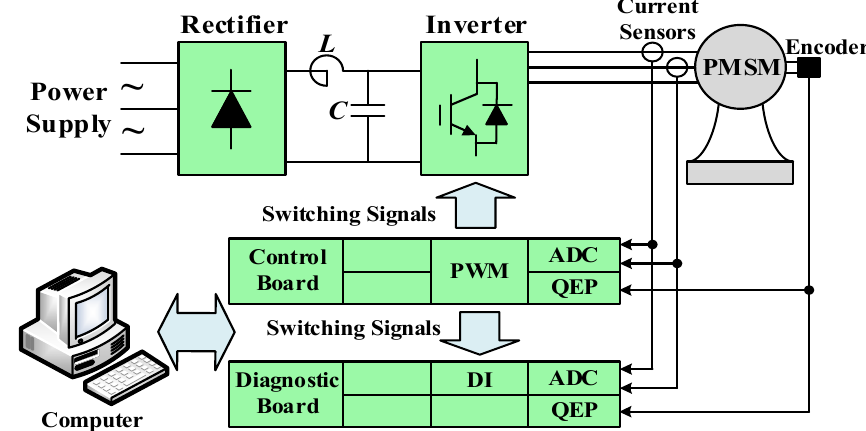
Figure 12. Scheme of the experimental setup.